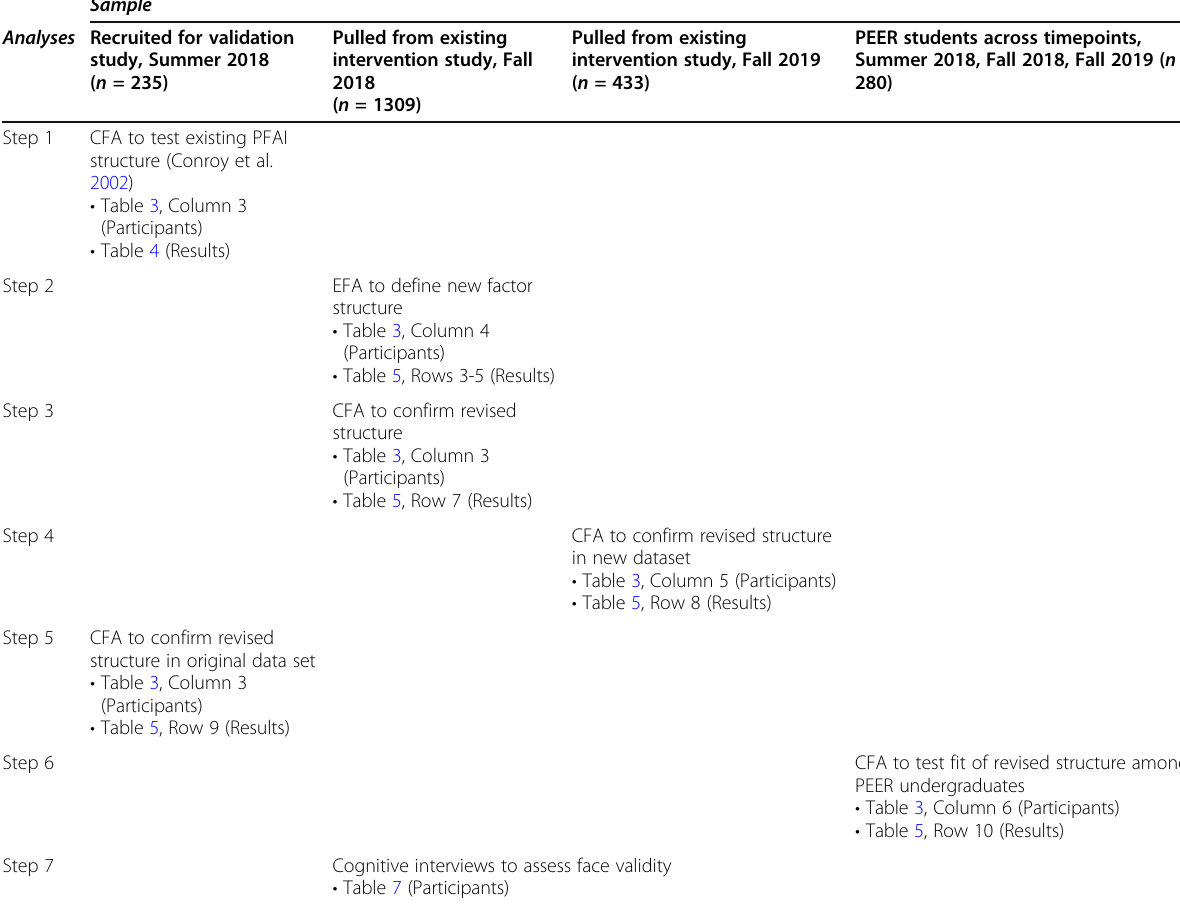
Table 2 Order of tests Sample Analyses Recruited for validation study, Summer